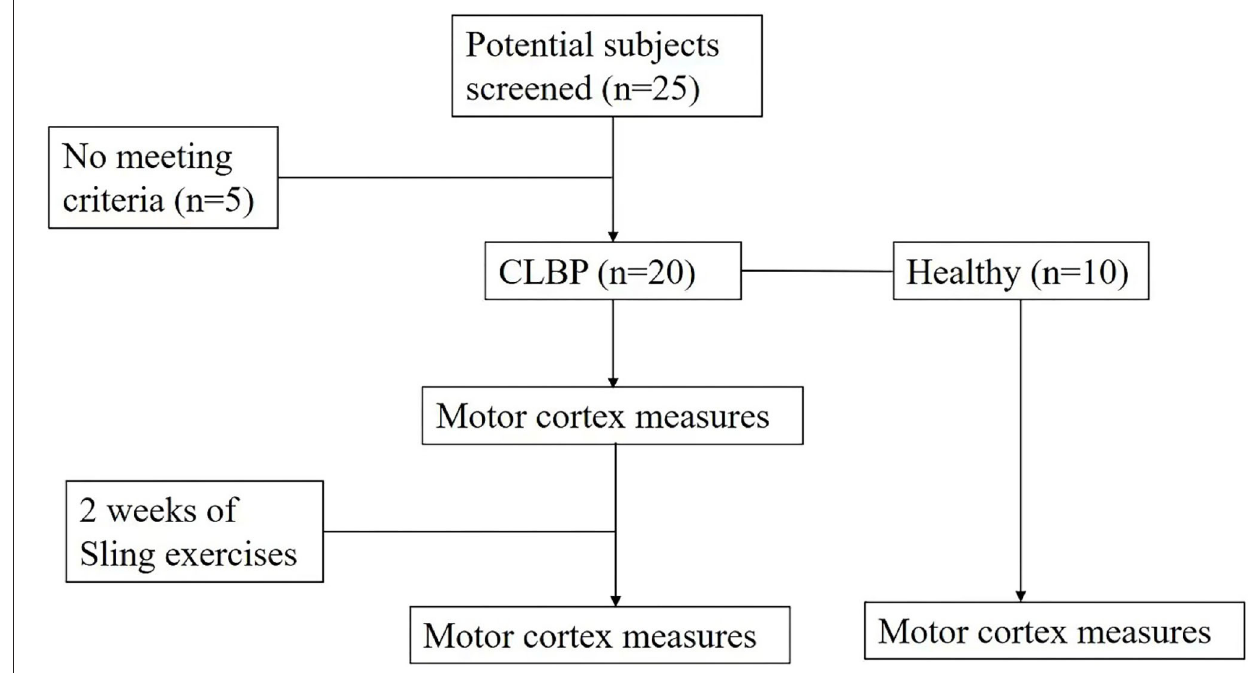
FIGURE 1 | Flowchart of individual screening and experimental protocol.